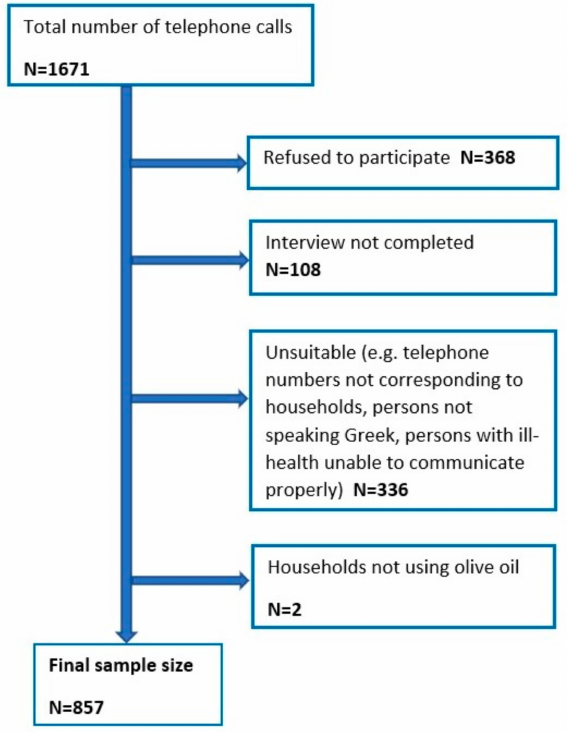
Figure 1. Flow chart of sampling